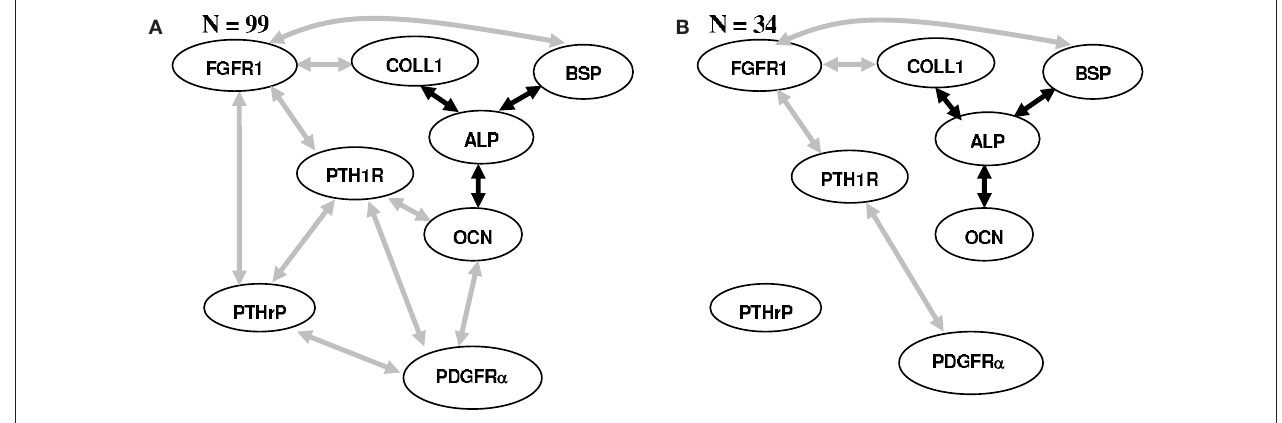
Figure 2 | Statistically significant Frs identified using three BSL techniques (PC, gS, iAMB) from the clonal gene expression data generated during osteoprogenitor differentiation with ( N = 99) colonies (A) and